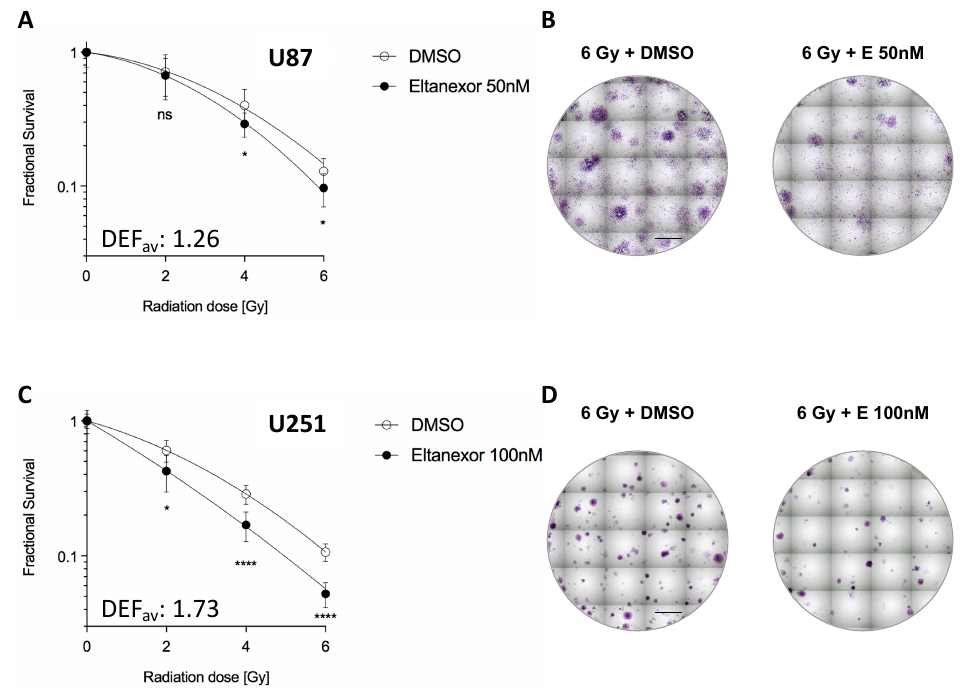
Figure 6. Effect of Eltanexor on the in vitro radiosensitivity of GBM cells in U87 (50 nM) and U251 (100 nM) cells. Viability was determined after either 14 (U87) ( A ) or 10 days (U251) ( C ). Left panel, fractional survival after irradiation in the presence of either solvent DMSO or Eltanexor (50 nM for U87 and 100 nM for U251 cells) at different doses of 0, 2, 4, and 6 Gy. The average dose enhancement factors (DEF) are provided for each cell line. Values are shown as mean ± S.D. from three independent experiments performed in triplicates. Statistical significance was determined by the Student’s t -test with *, p < 0.05 and ****, p < 0.0001. Right panel, colony formation assay demonstrating a significant effect of Eltanexor (50 nM and 100 nM) on radiation sensitivity in U87 and U251 cells. Scale bars in ( B , D ), 5 mm.